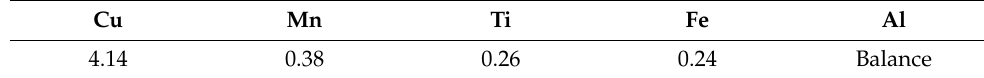
Table 1. Real chemical compositions of the ZL205A alloy